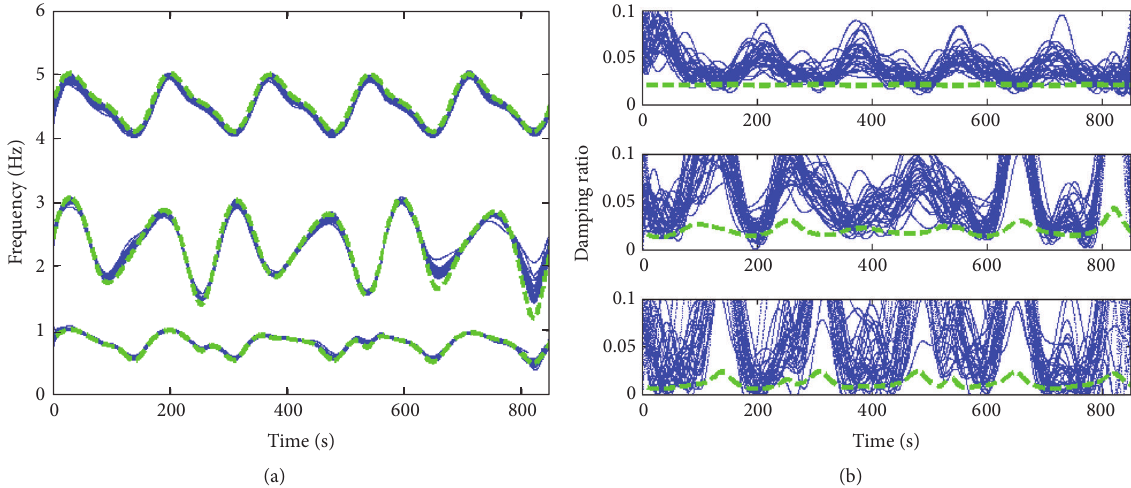
Figure3:RPLR-FS-TARMAbasedmodalparameterMonteCarloestimates(30realizations):(a)naturalfrequencyestimatesand(b)damping ratio